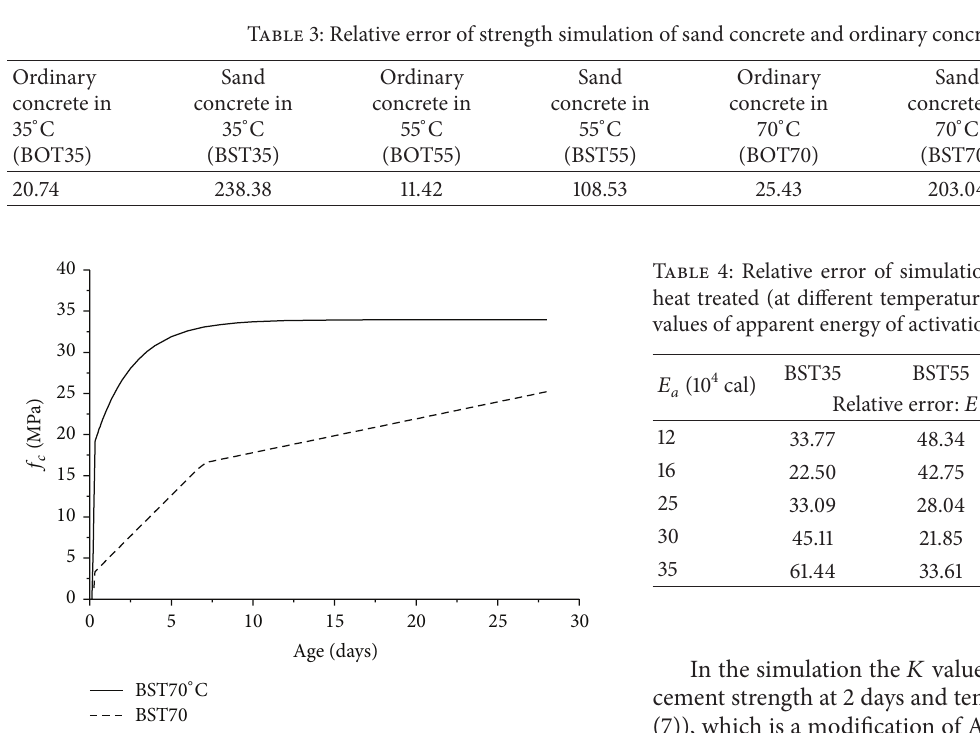
Figure 9: Simulated and experimental strength development curves of heat treated sand concrete at 70 ∘ C.